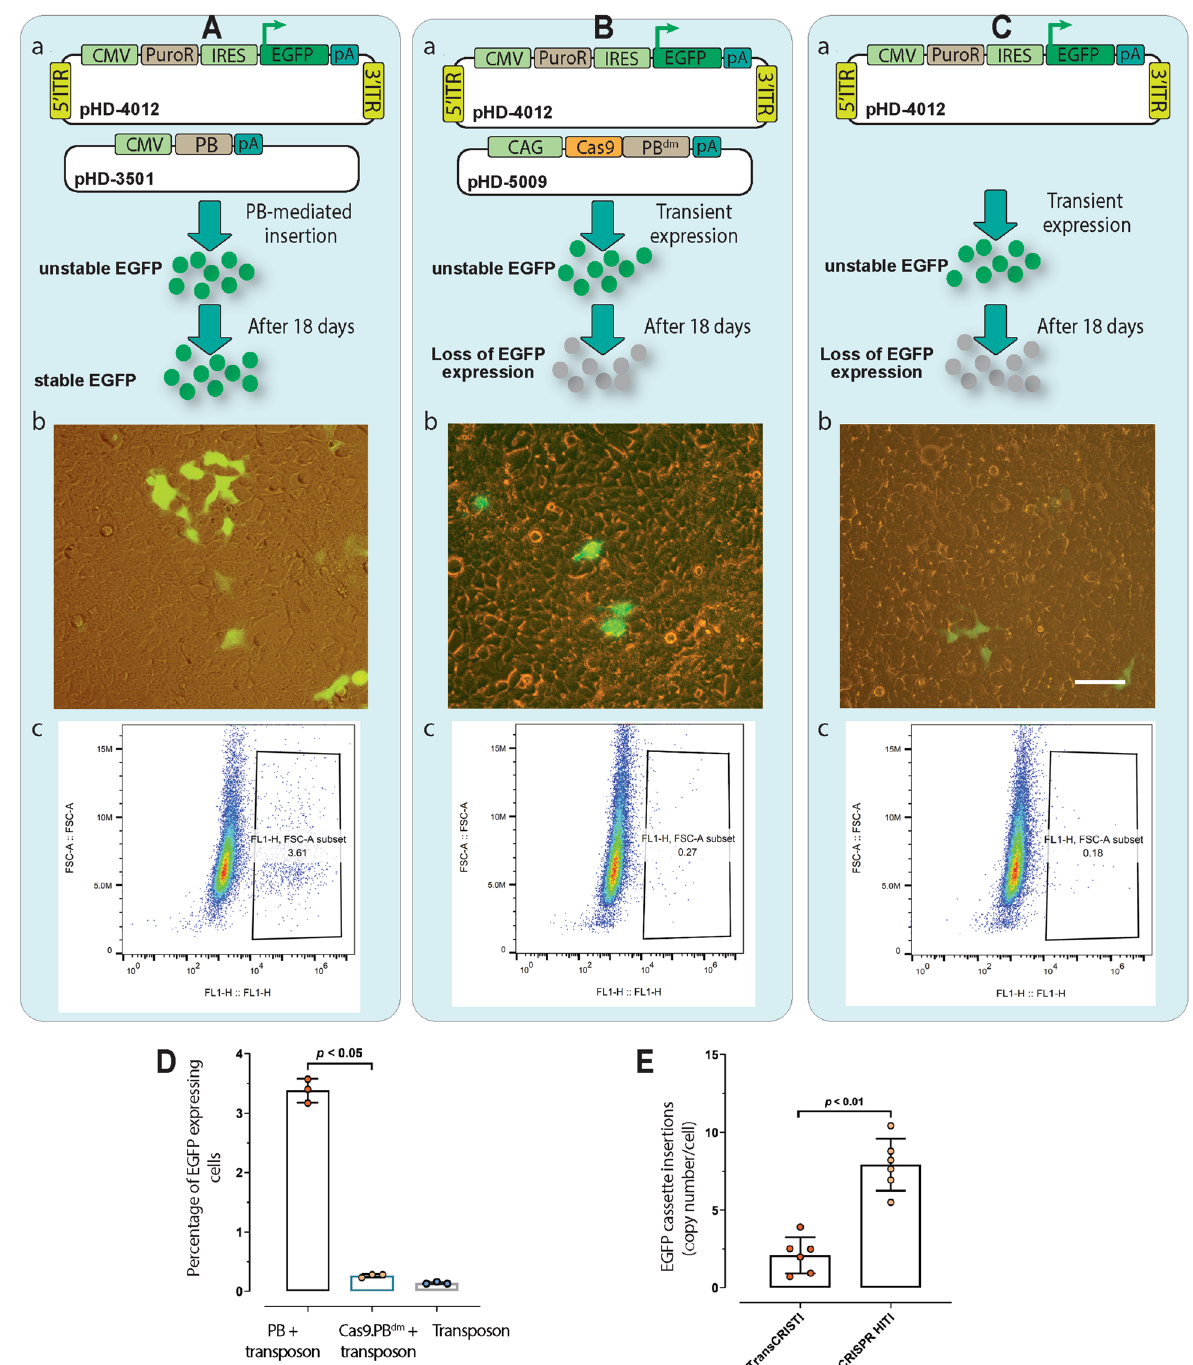
Figure 5. Assay to determine random insertion of the transposon for Cas9.PB dm and wild-type piggyBac transposase and evaluation of specific and off-target insertions mediated by the TransCRISTI and CRISPR HITI methods. ( A ) Measurement of random insertion events mediated by wild-type PB. ( B ) Measurement of random insertion events mediated by Cas9.PB dm . ( C ) Measurement of random insertion events in cells transfected with only the transposon donor. Panels Aa, Ba, and Ca schematically depict experiments for each group. Panels Ab, Bb, and Cb show merged brightfield and fluorescent images. These representative images show cells that are transfected and cultured for 18 days in each group. The scale bar indicates a length of 100 μm. ( C ) Panels Ac, Bc, and Cc show representative flow cytometry analysis for each group. ( D ) Percentage of stable EGFP-expressing cells determined for each group. ( E ) In isogenic cell lines using qPCR assay the copy number of specific genomic insertion of the EGFP transposable cassette was compared between the TransCRISTI and CRISPR HITI methods. The insertions were calculated relative to the copy number of the EGFP gene in a reference isogenic cell